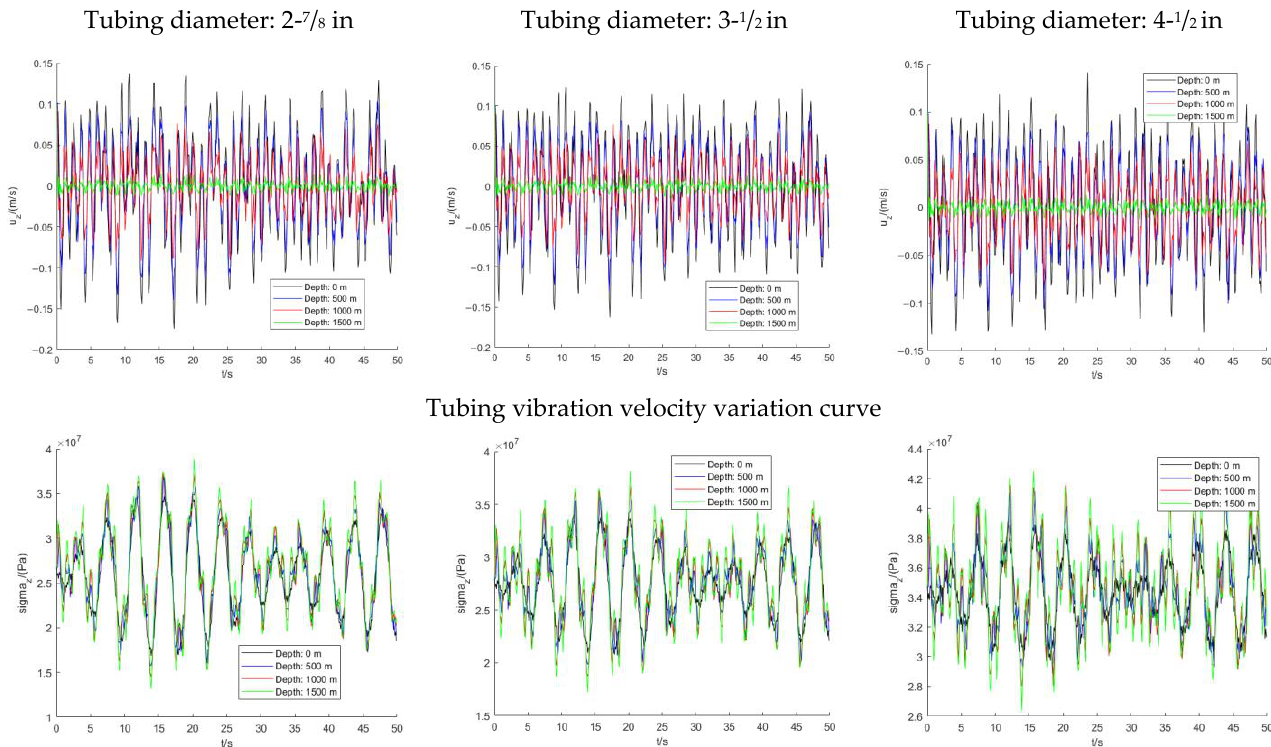
Figure 3. Variation curve of tubing parameters at different diameters.